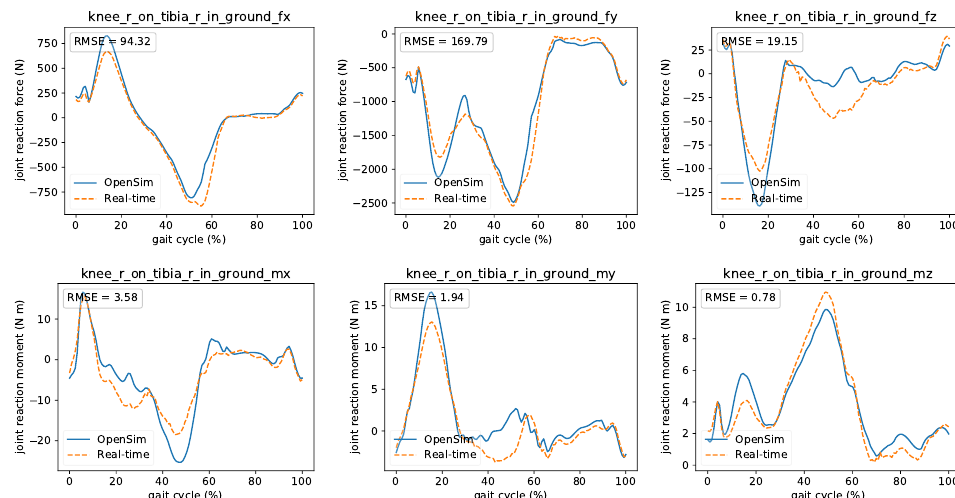
Figure 13. Comparison between OpenSim ’s (offline) and real-time’s joint reaction loads (forces and moments) on the knee using the muscle forces obtained by the proposed optimization. For comparison reasons, the curves were shifted to compensate for the time lag introduced by the